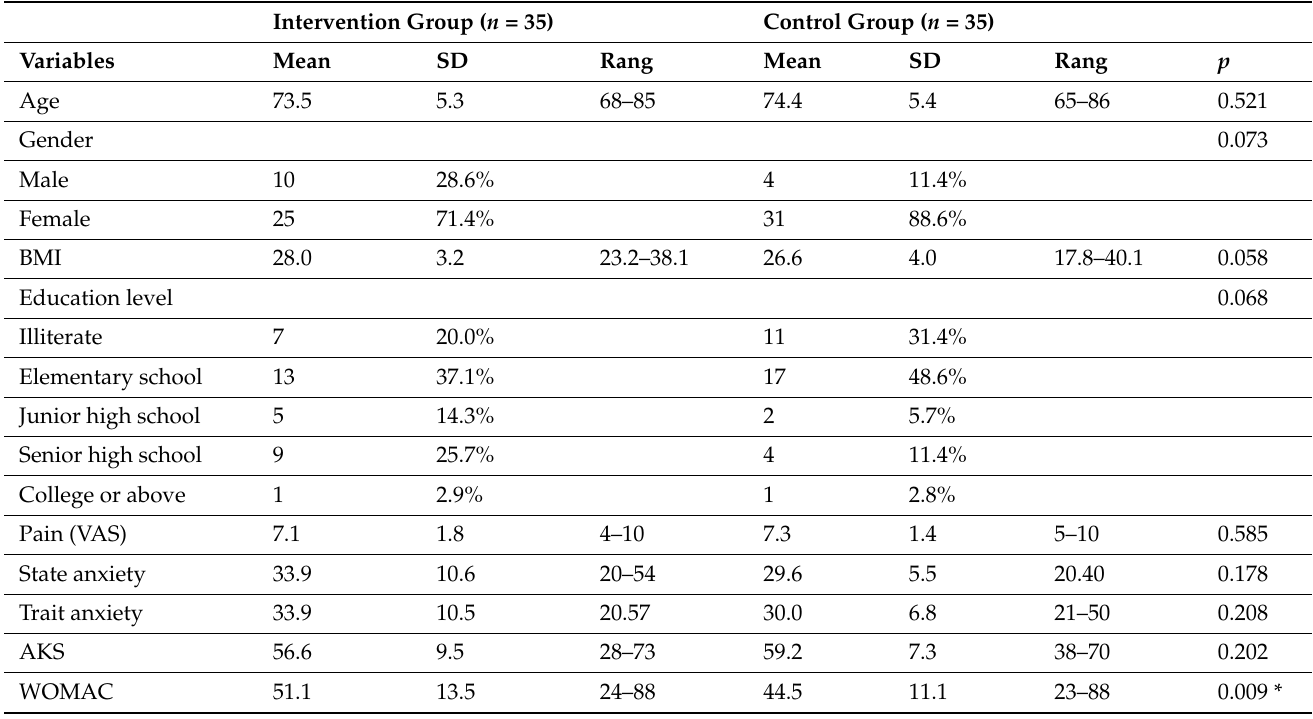
Table 1. The demographic data in